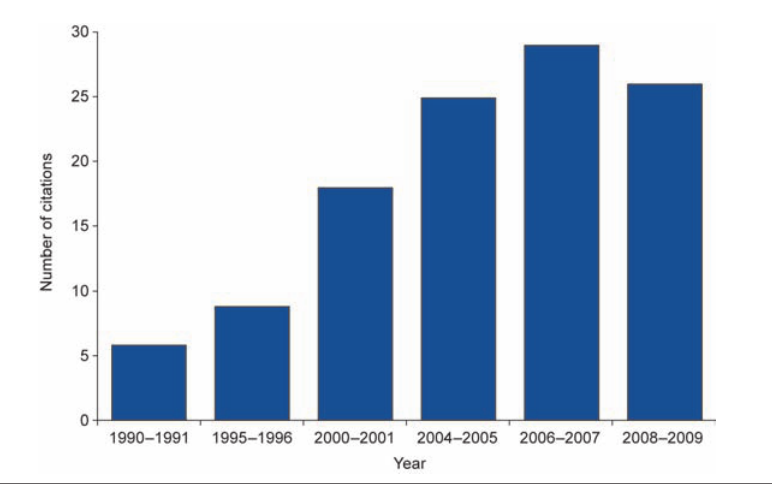
Figure 2. Number of randomized, controlled clinical trials in elderly patients (>65 years of age) with cancer over the past 20 years (using the Medline search terms: cancer/elderly; title/abstract; +65; randomized controlled trial). 4 Reprinted from Aapro MS. Launching the Journal of Geriatric Oncology: a historical milestone. J Geriatr Oncol